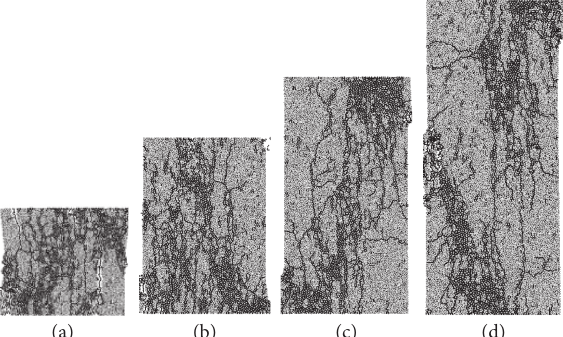
Figure 6: Failure modes of rocks with different aspect ratios.